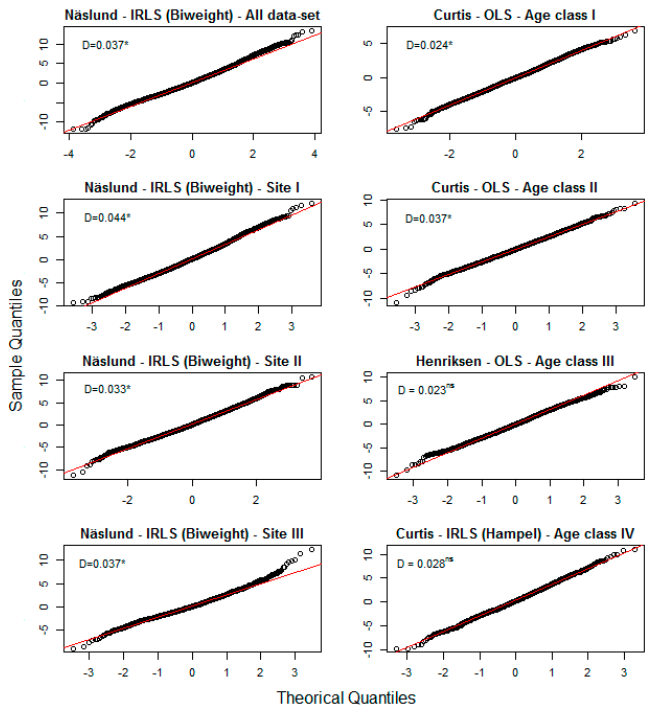
Figure 6. Graphical analysis of normality for the most representative model fitted by site-index and age classes for Ochroma pyramidale (balsa-tree) stands in Ecuador. D: Lilliefors’ test value. * is statistically significant at p < 0.05, ns is not statistically significant at p <